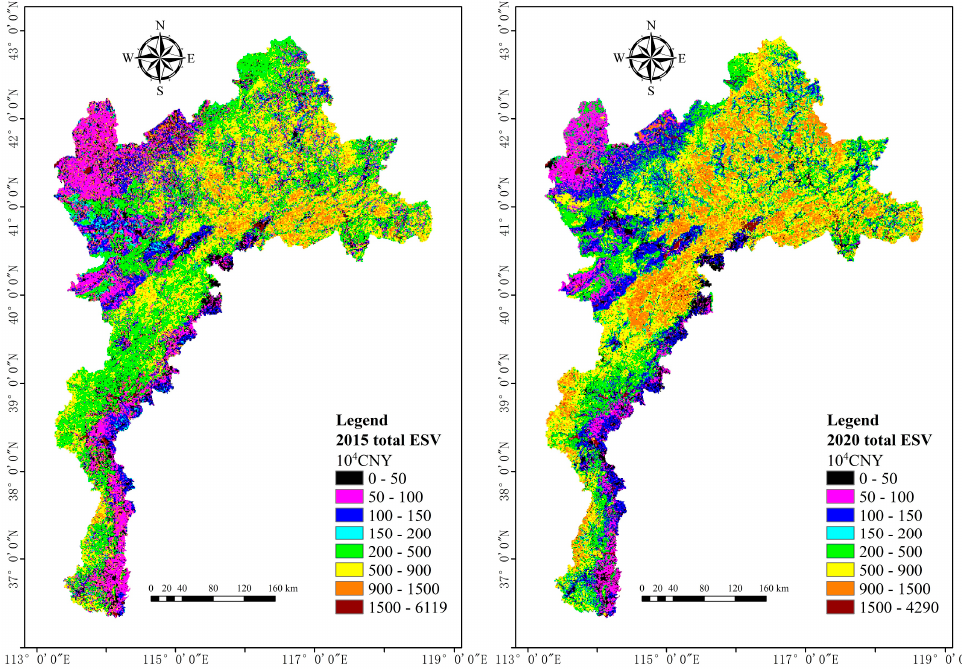
Figure 2. Spatial distribution of the total ESV at grid scale in 2015 and 2020.